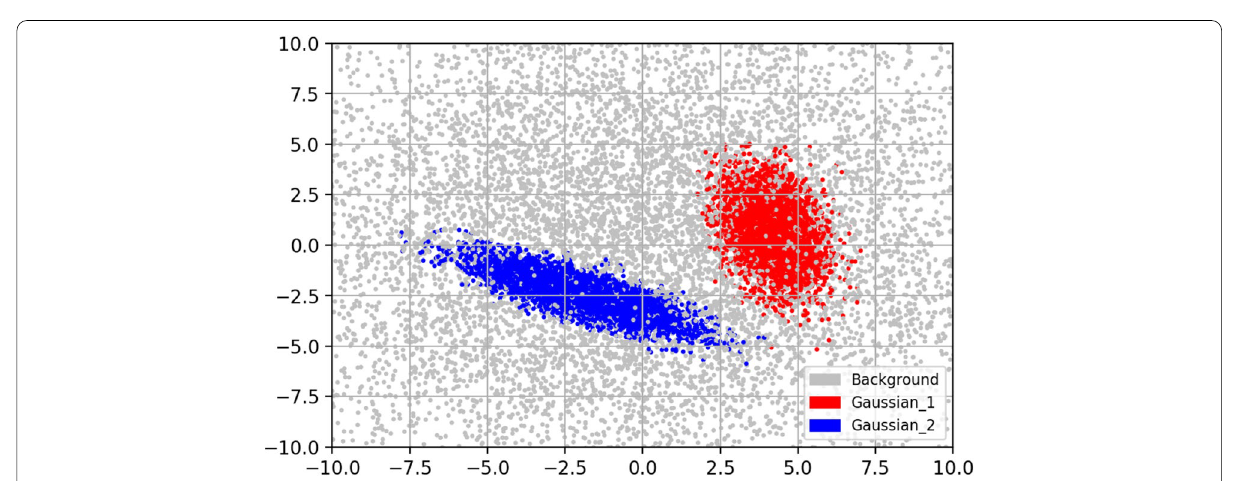
Fig. 5 Scatter plot of sample points which contains three classes: two Gaussian clusters plus a